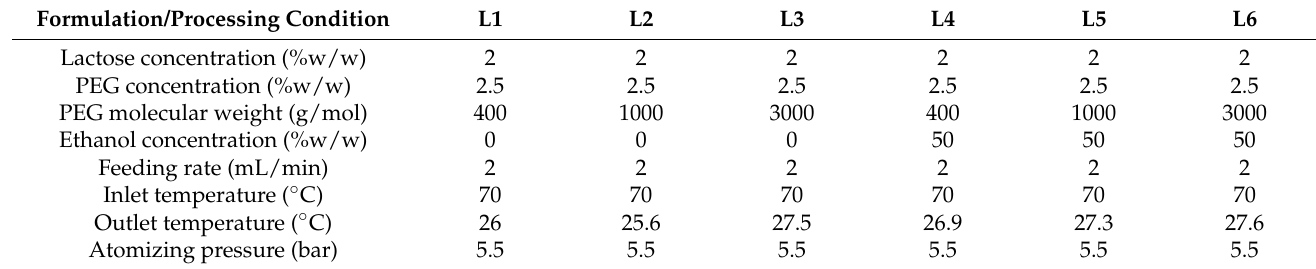
Table 1. Formulation and process parameters of lactose-PEG